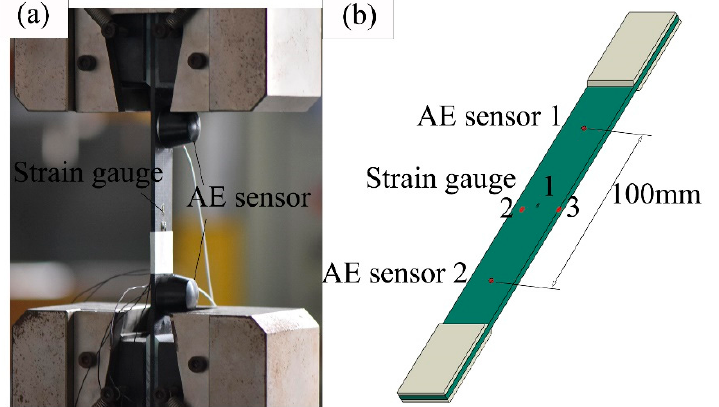
Figure 2. Tensile experiment with acoustic emission detection. ( a ) Fixture and ( b ) locations of the AE sensors and strain gauges.